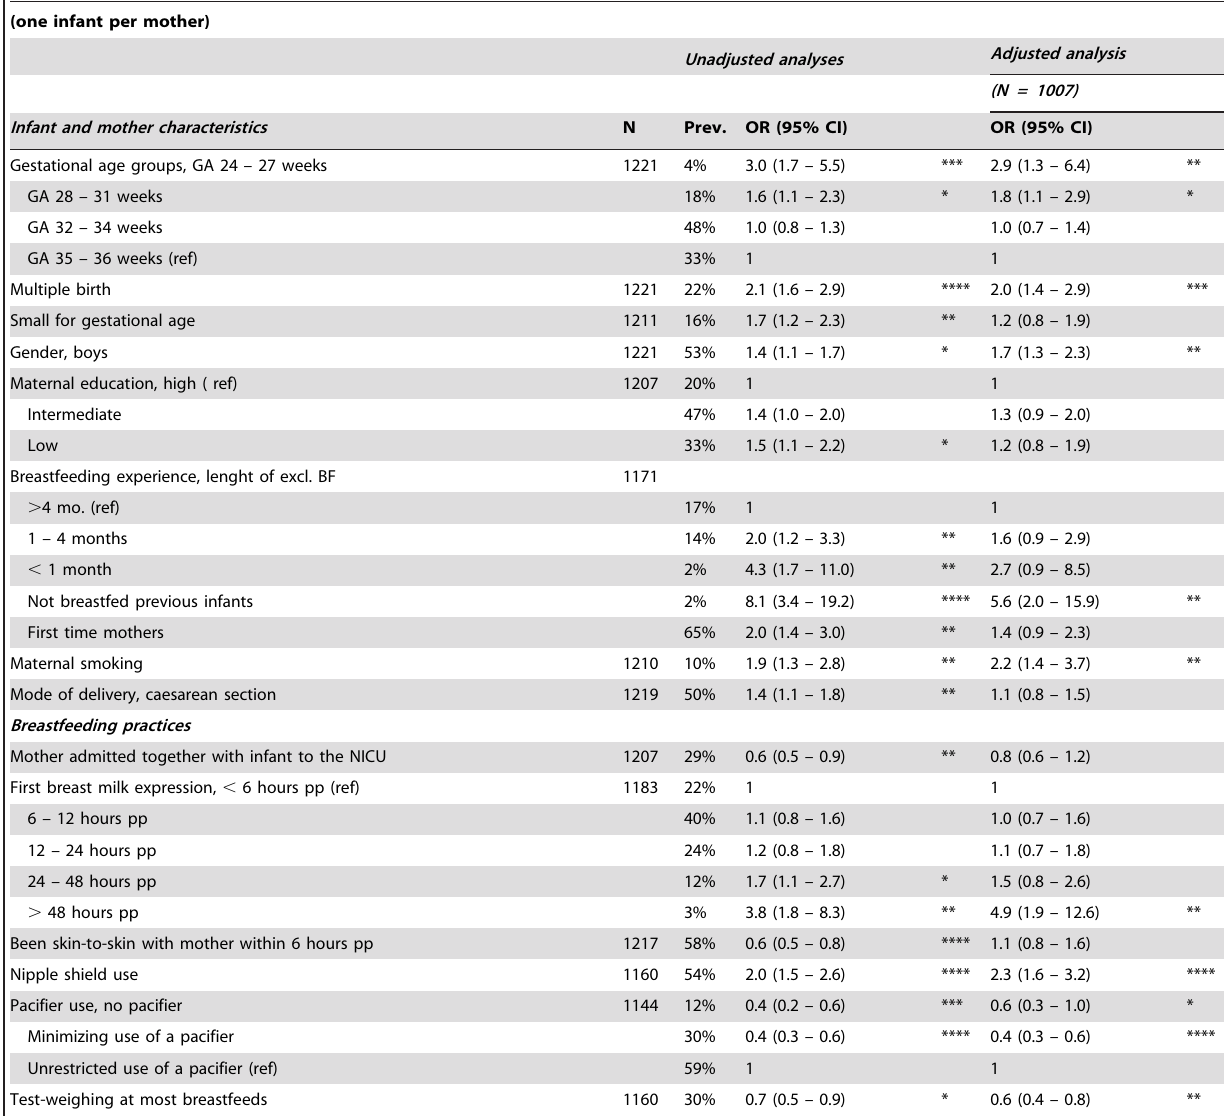
Table 3. Odds for failure of exclusive breastfeeding at discharge from NICU to home.